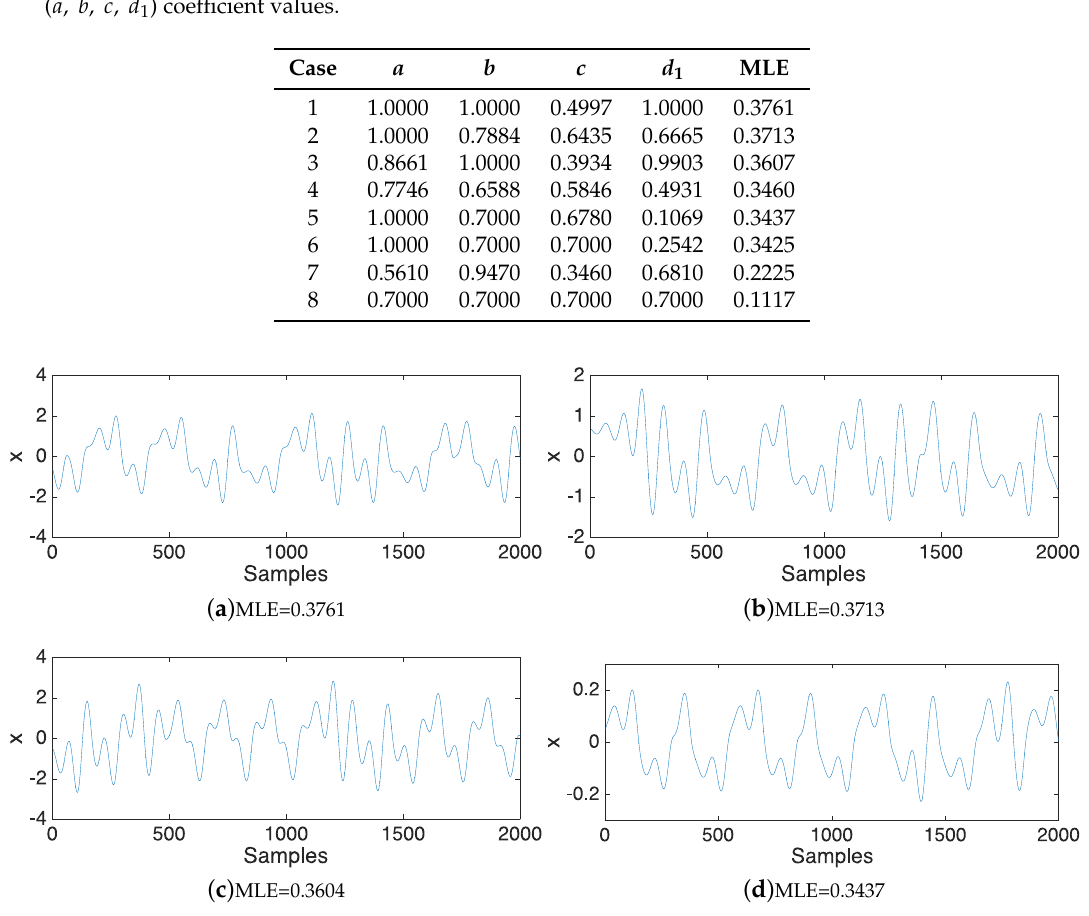
Table 1. Optimized maximum Lyapunov exponent (MLE) for a two-scroll attractor and their associated ( a , b , c , d 1 ) coefficient values.